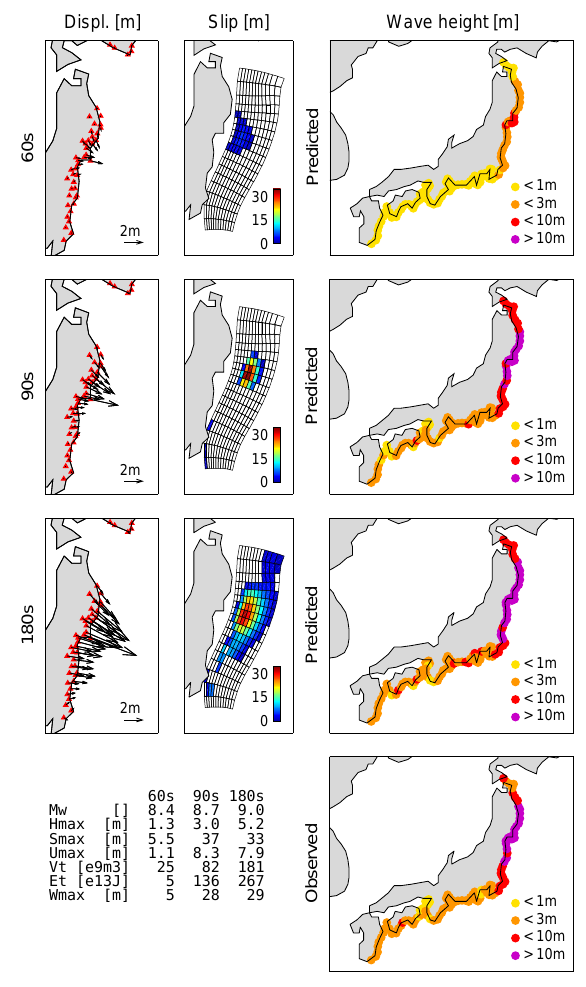
Fig. 2. Real-time GPS displacements (left panels) are inverted for slip at the fault (middle panels). These source models are used to compute estimated coastal tsunami wave heights (right panels). Lower right panel: observed wave heights. The table contains key characteristics of the three succeeding earthquake and tsunami mod- els. M w : moment magnitude, H max : maximum observed horizontal displacement at the GPS stations, S max : maximum inverted slip at the fault, U max : maximum modeled uplift at the sea floor, V t : initial tsunami volume, E t : initial tsunami potential energy, W max : maxi- mum estimated wave height at the coastal points of